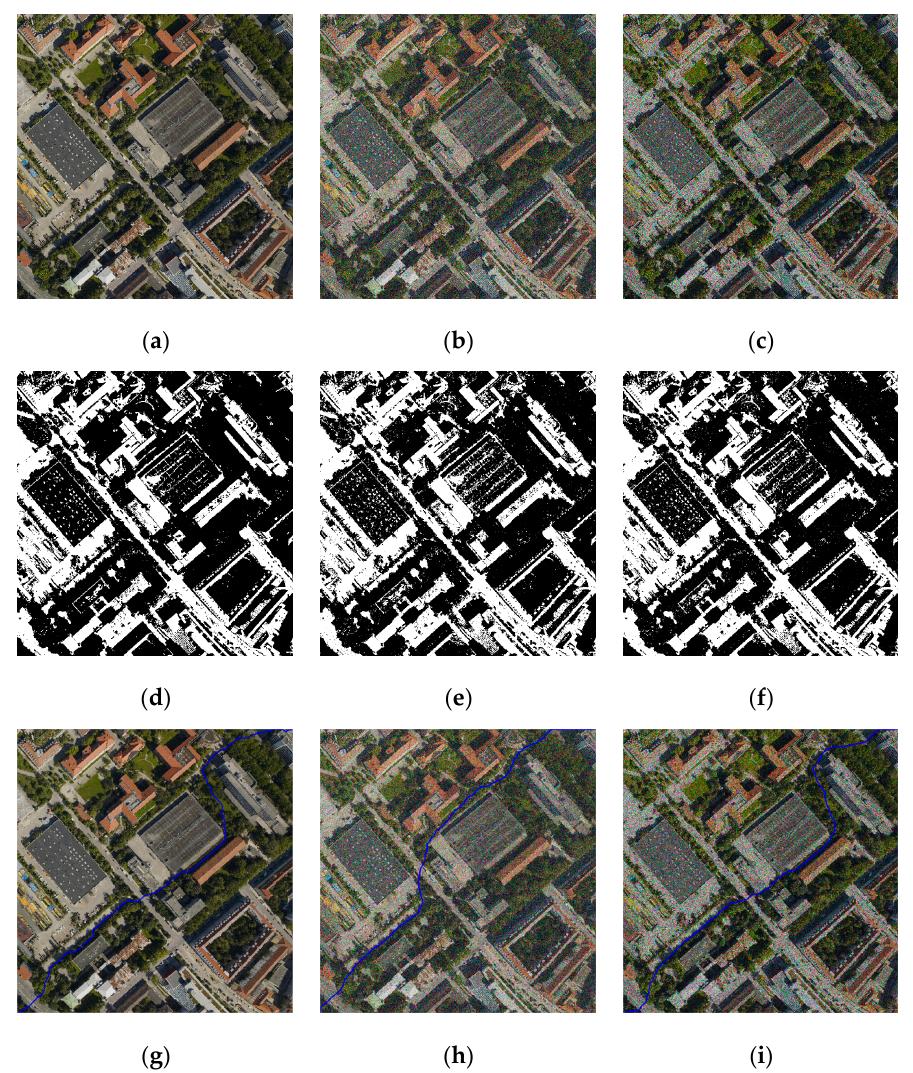
Figure 9. Experimental results of suppressing noise: ( a ) image without noise; ( b ) image with Gaussian noise; ( c ) image with Gamma noise; ( d ) segmentation result of ( a ); ( e ) segmentation result of ( b ); ( f ) segmentation result of ( c ); ( g )seamline based on ( d ); ( h ) seamline based on ( e ), ( i ) seamline based on ( f ).